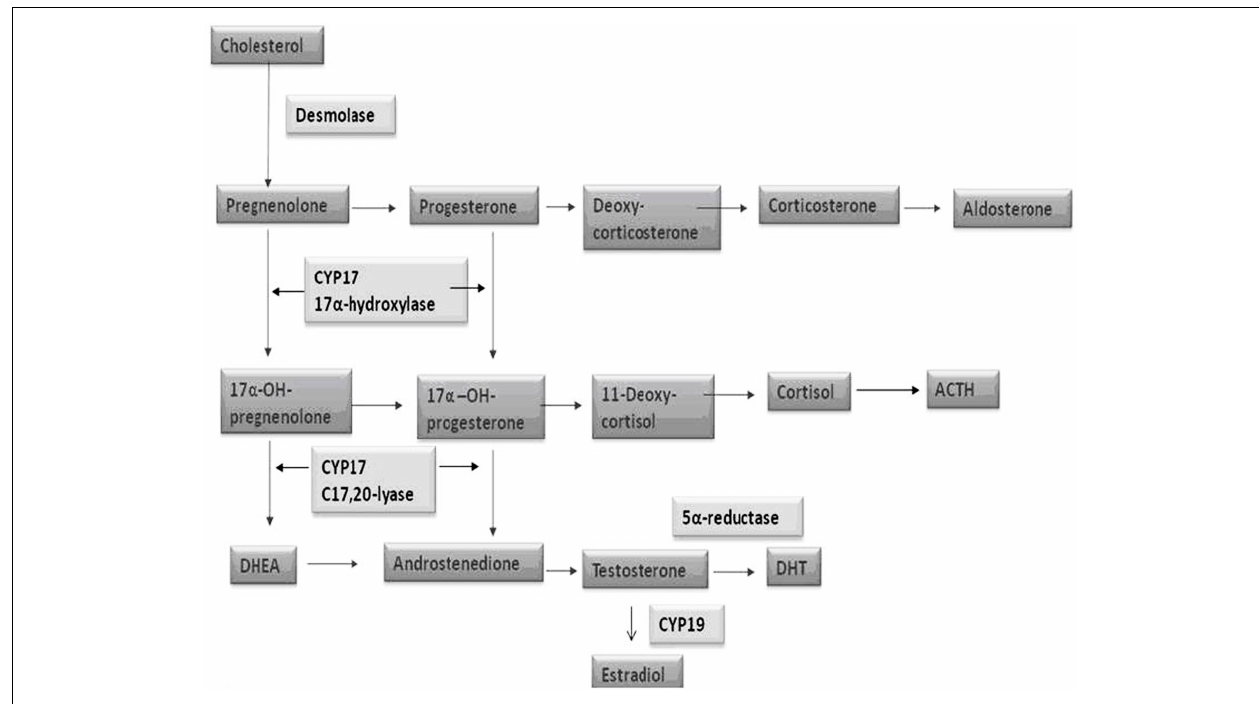
FIGURE 3 | Steroid